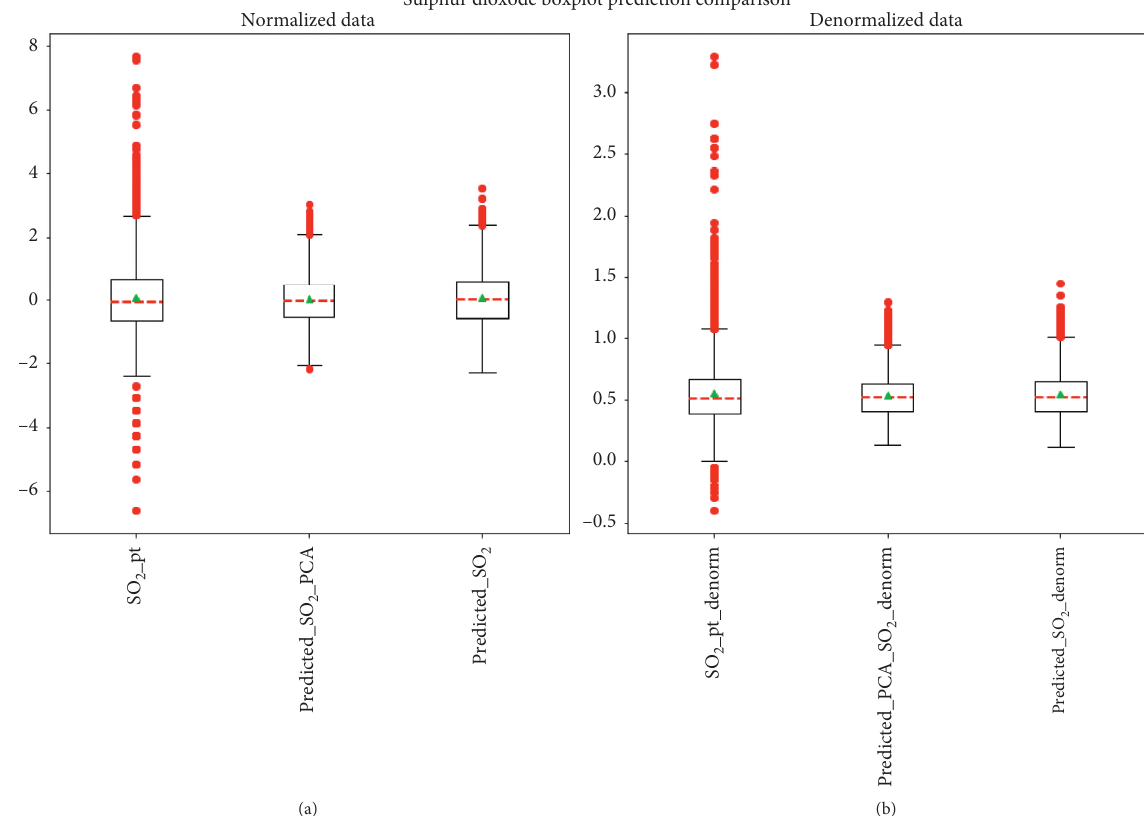
Figure 10: Boxplot of predicted and observed sulfur dioxide